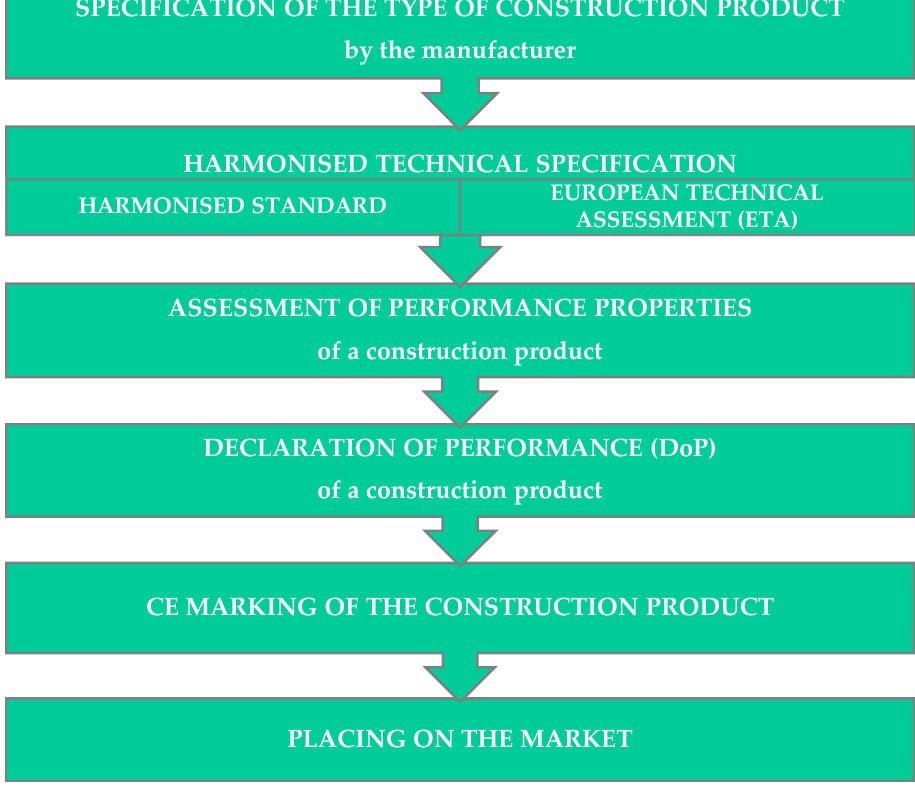
Figure 1. Diagram of placing construction products on the market [4].